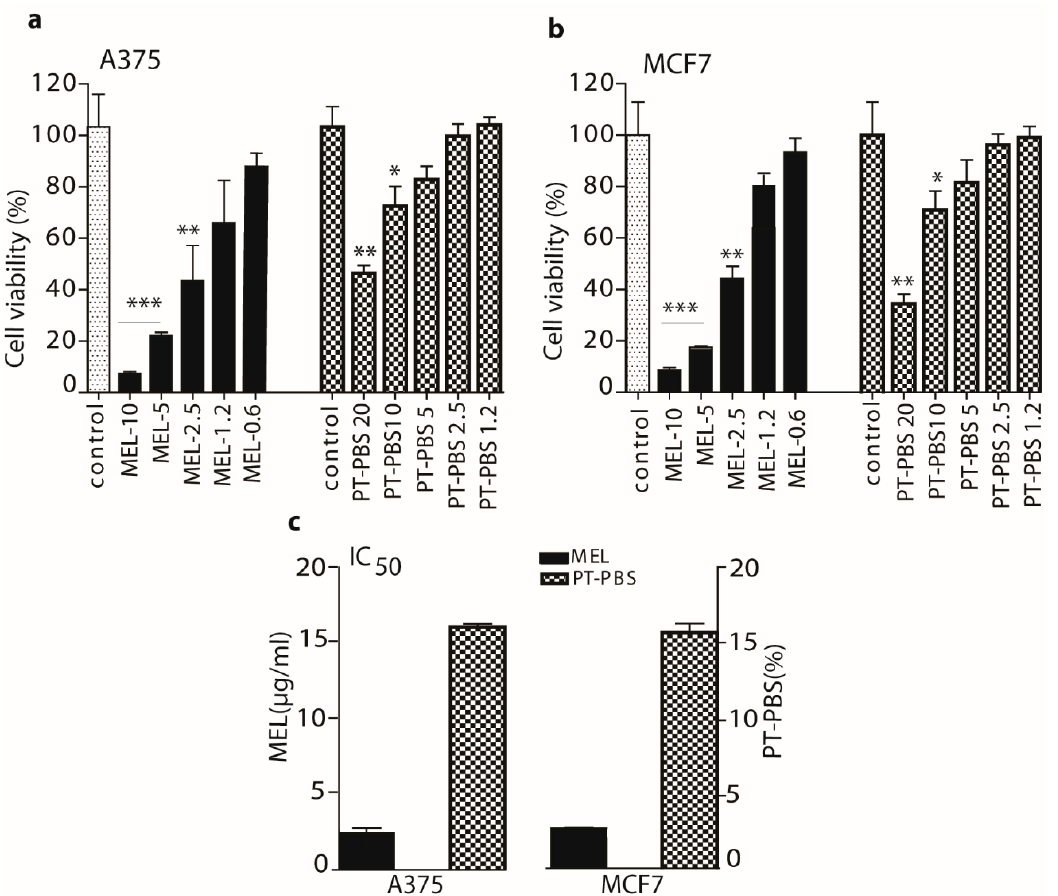
Figure 3. Estimation of optimal doses of MEL and PT-PBS alone, for the cytotoxicity of A375 and MCF7 cells. We measured the cell viability of ( a ) A375 cells, and ( b ) MCF7 cells, at different doses of MEL and PT-PBS, after 24 h incubation. ( c ) Half maximal inhibitory concentration (IC50) values of MEL and PT-PBS. Data shown as mean ± SD; * = p ≤ 0.05; ** = p ≤ 0.01; *** = p ≤ 0.001.